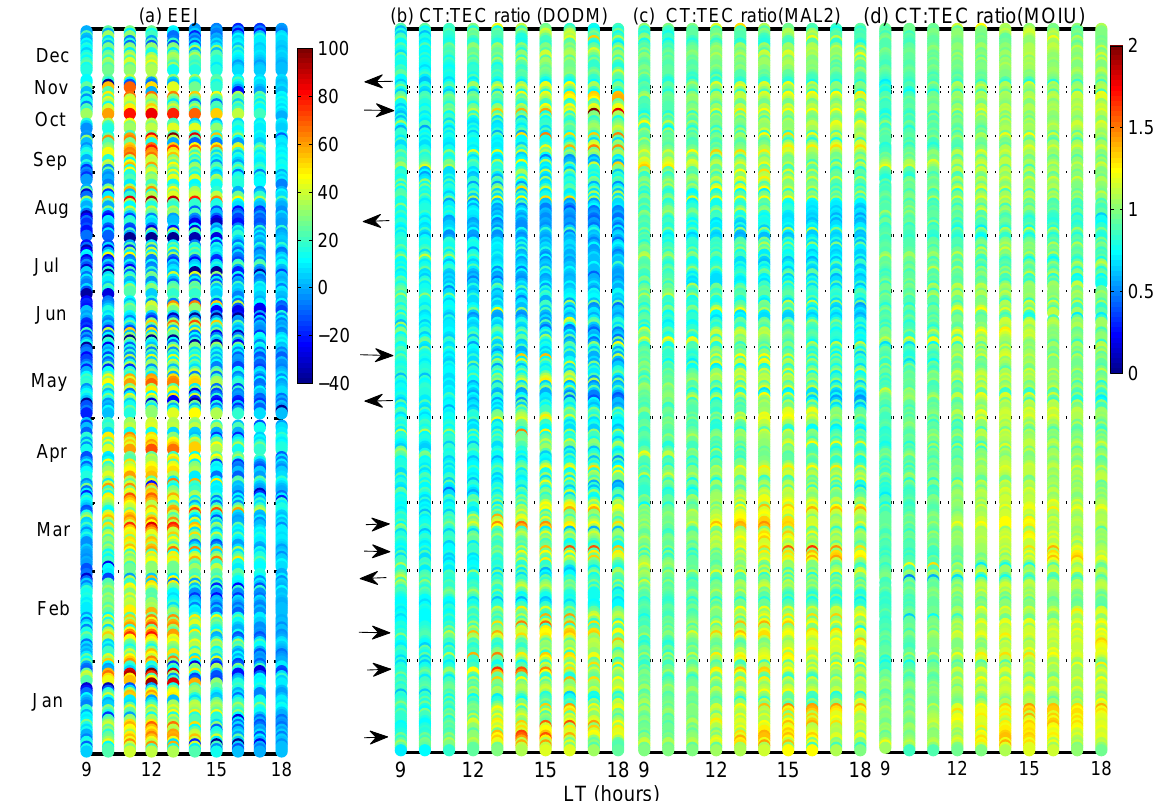
Figure 4. Panel (a) shows variation of the hourly EEJ as a function of LT during days in monthly bins. Corresponding CT:TEC ratios over DODM, MAL2 and MOIU are shown in (b–d) , respectively. Arrows pointing right and left indicate some cases of the prominent EIA during the strong daytime EEJ and the background-level EIA during the weak daytime EEJ,